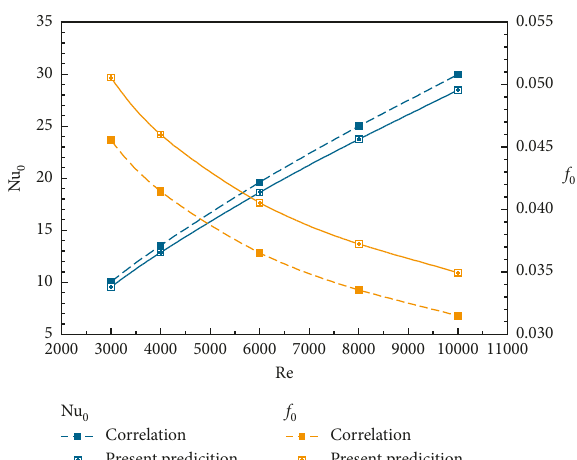
Figure 3: Validation of the smooth circular tube for the turbulent flow.